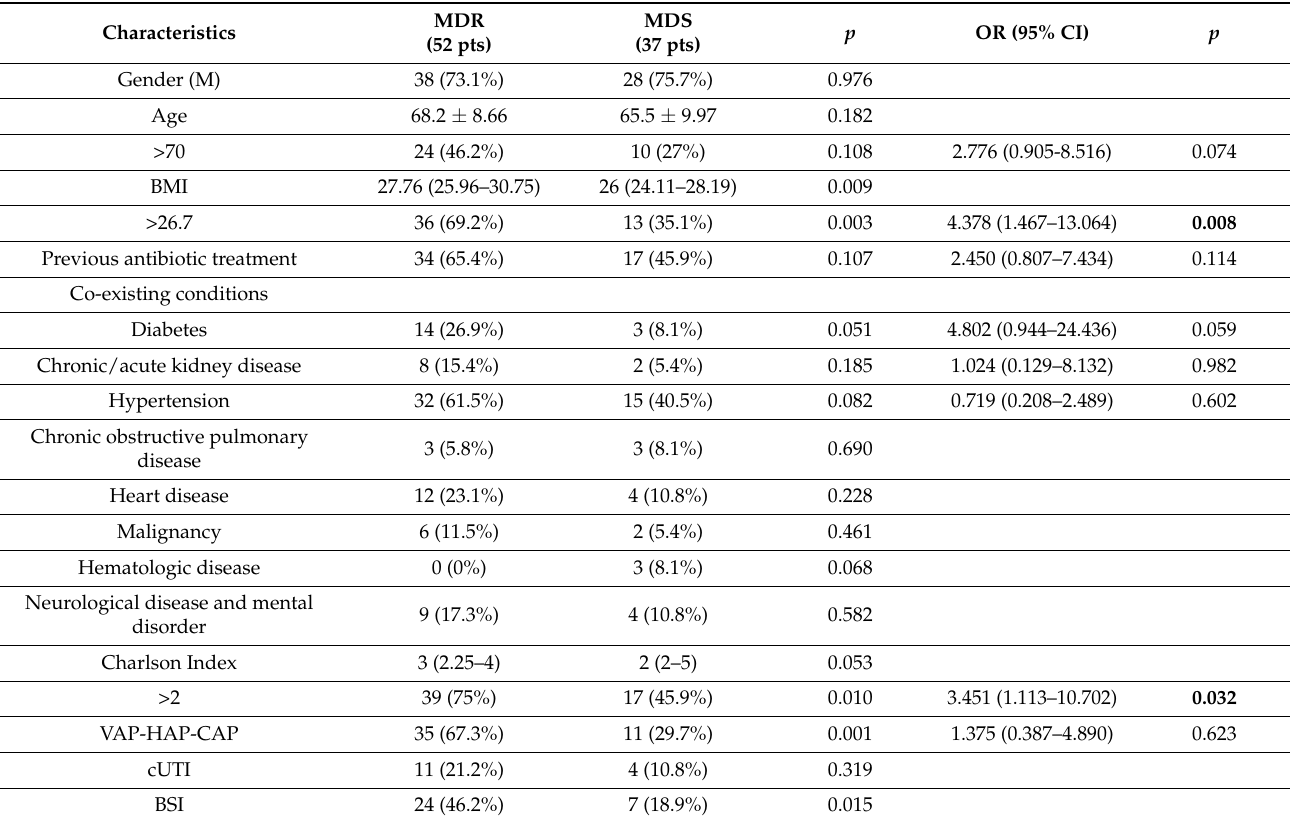
Table 4. Risk factors for secondary infections due to MDR pathogens.